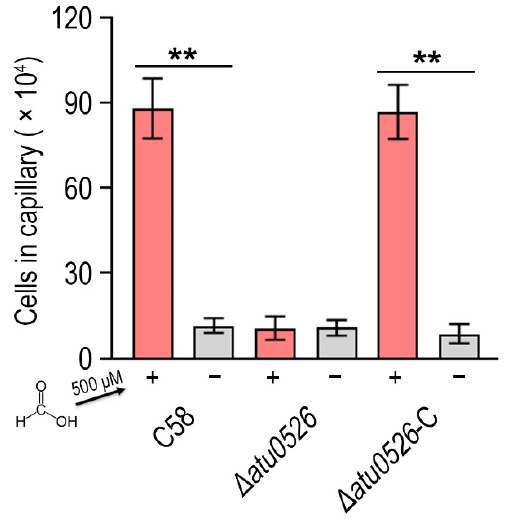
Figure 5. The effect of atu0526 on the chemotaxis of A. fabrum toward formic acid. A. fabrum C58, ∆ atu0526 , ∆ atu0526 -C were tested in a capillary assay with 500 µ M formic acid. + Represents 500 µ M formic acid was applied, while—represents the case without formic acid. Data are the means of ten biological replicates with the SD. Significant differences ( p < 0.01) are indicated by **.